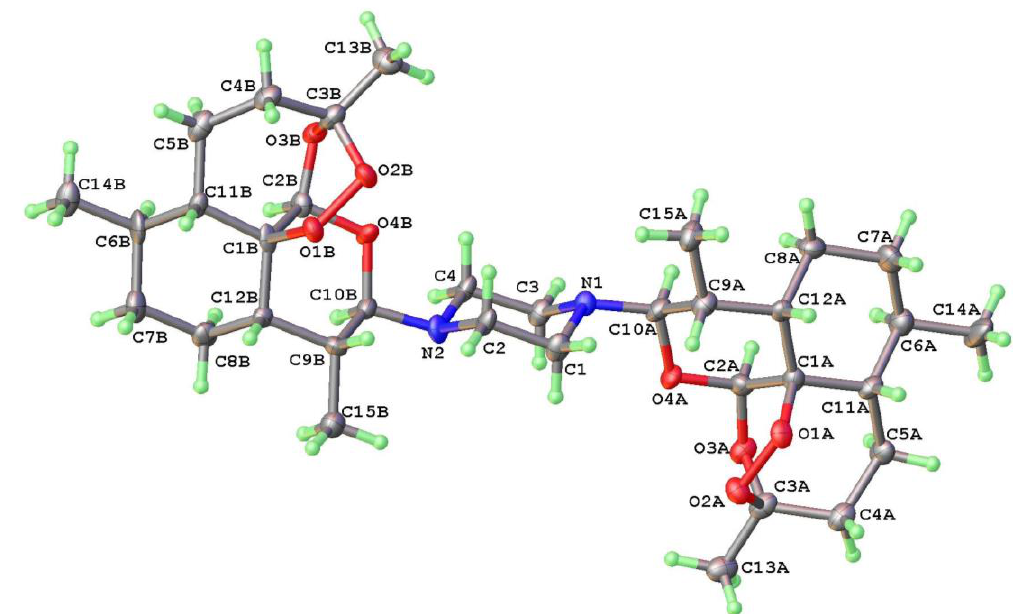
Figure 4. ORTEP plot from X-ray crystallographic structural determination of the 1,4-bis-DHA piperazine 16 indicating diaxial arrangement of H-9 and H-10 attached to each of the pyran rings in the respective artemisinin units, the chair piperazine and α -equatorial C-10 to N bonds. Numbering in the artemisinin A and B units is as for artemisinin in Figure 1.